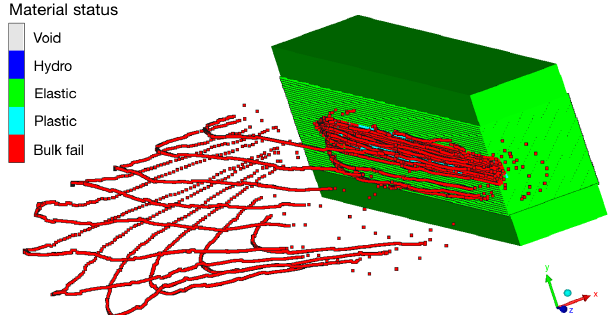
FIG. 19. Status of the TCTH.4R5.B2 after the impact in Case 3: the material of the TCT jaw is deeply damaged and no longer recoverable (threshold 3). The traces outside the collimator block represent the ejections of jaw